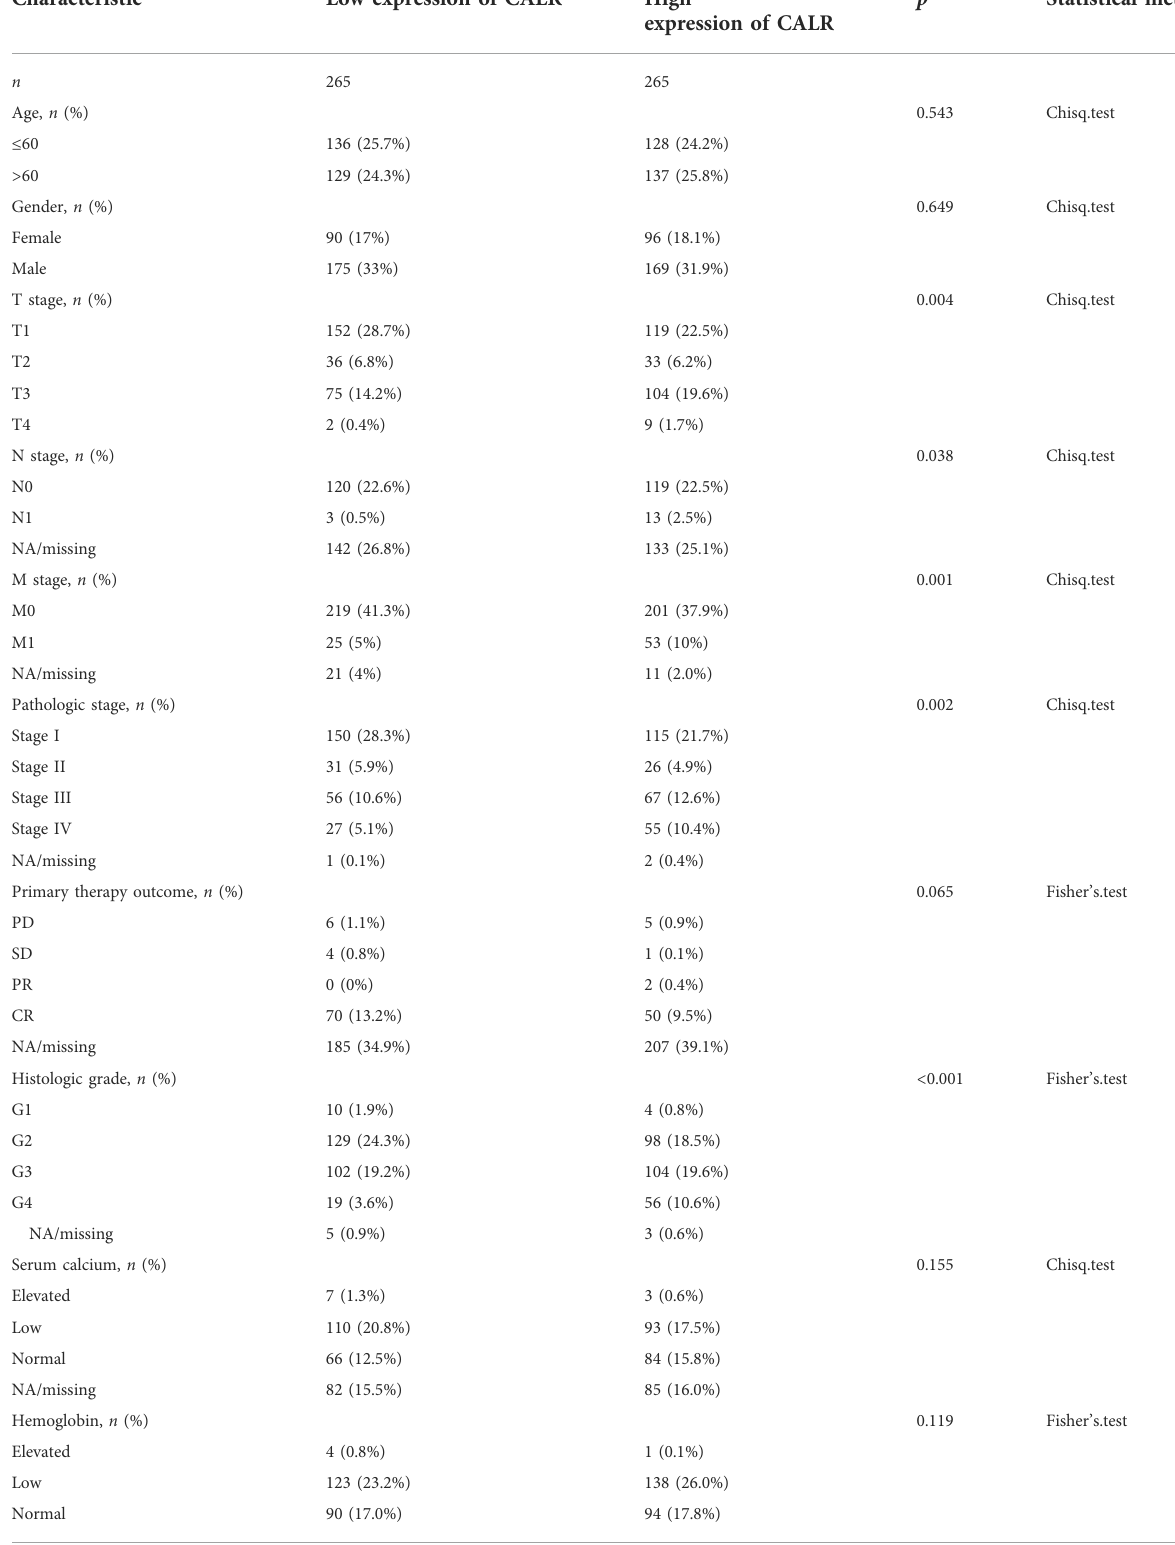
TABLE 1 Relationship between the expression of CALR and clinical